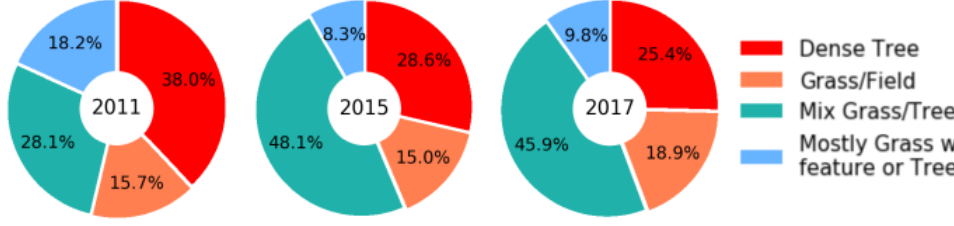
Figure 3. Percentage of each cluster in the CoMo area for the years 2011, 2015, and